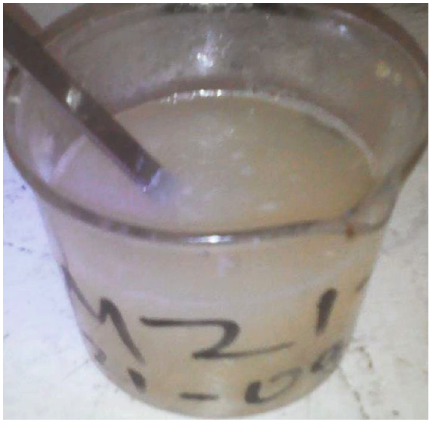
Figure 3: Appearance of Sclerocarya birrea fruit pulp.